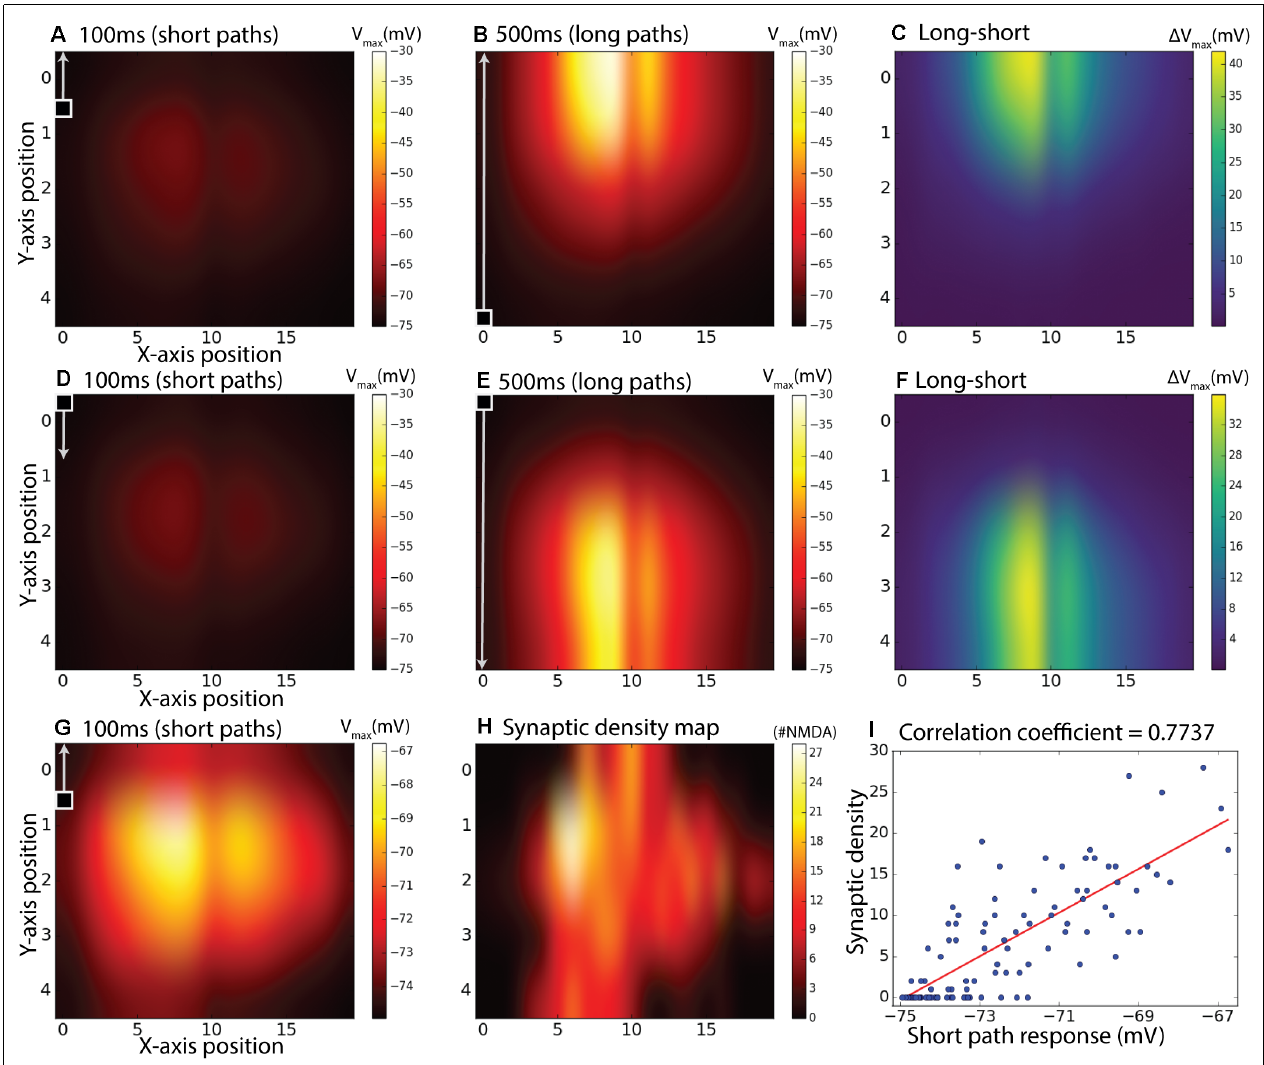
FIGURE 7 | Subdivided long continuous paths vs. short paths, the difference between them, and comparison with synaptic density map. The 100 ms measurement period is indicated with a square target with an arrow and also applies to the second row (D–F) . g max = 8.25 pS was used. (A) Maximum membrane potential from short (100 ms) paths starting at positions corresponding to a 20 by 5 matrix over the dendritic tree. (B) Maximum membrane potential from continuous target paths with responses subdivided to the same paths as in (A) . In (A,B) , the targets were moving upward. (C) Equals difference between (B) and (A) to achieve a response without response elicited by inhomogeneous synaptic density. (D–F) is the same as (A–C) but with downward moving targets instead of upward. Panel (G) is the same as (A) but with individual color-bar scale. Panel (H) is a synaptic density map showing the number of synapses (sections) in the specified area. Panel (I) is a scatter plot of (G,H)